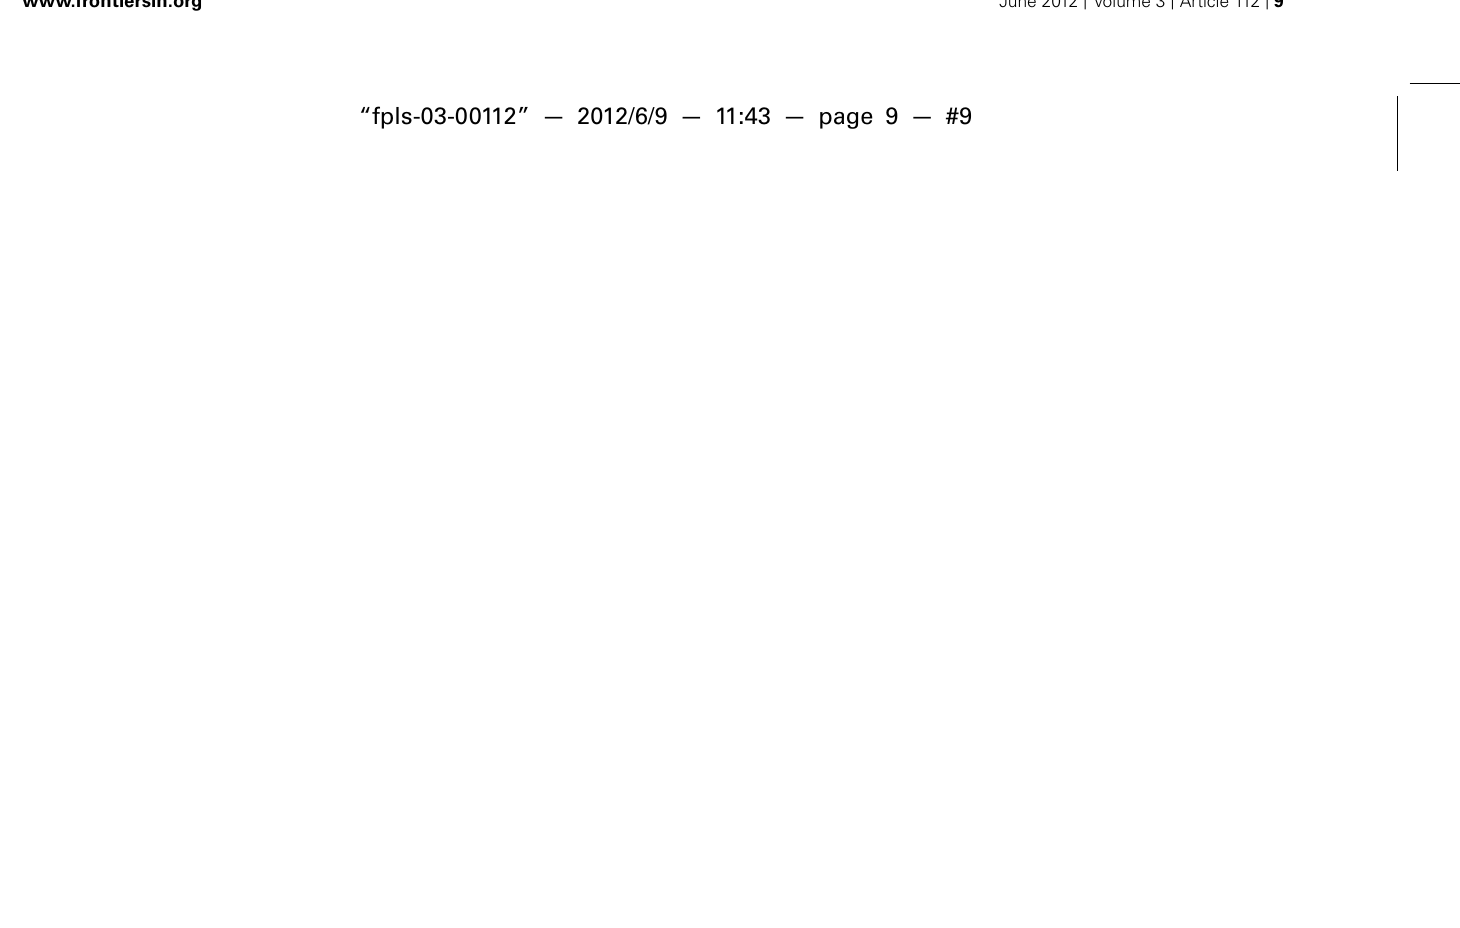
White bars represent control treatments, black bars, B55-inoculated plants (PLSD test of an ANOVA between mock- and B55-inoculated plants: * P < 0.05). dpi, days post-inoculation; CFU, colony forming unit; FM, fresh mass; n.d., not detected. n = 40 forWT–,WT + , and 35S-etr1 + ; n = 23 for 35S-etr1 at start of measurements (46 dpi); n = 5 for (H)